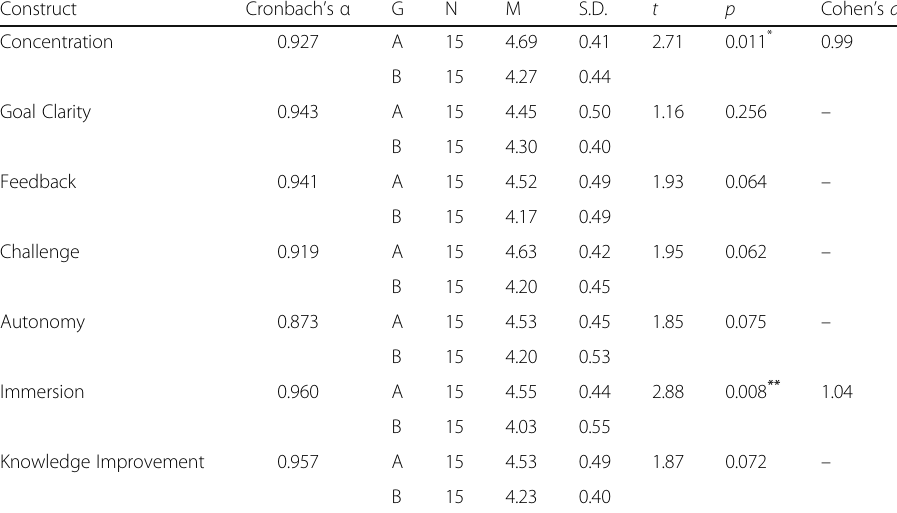
Table 10 The result of t-test in the EGameFlow